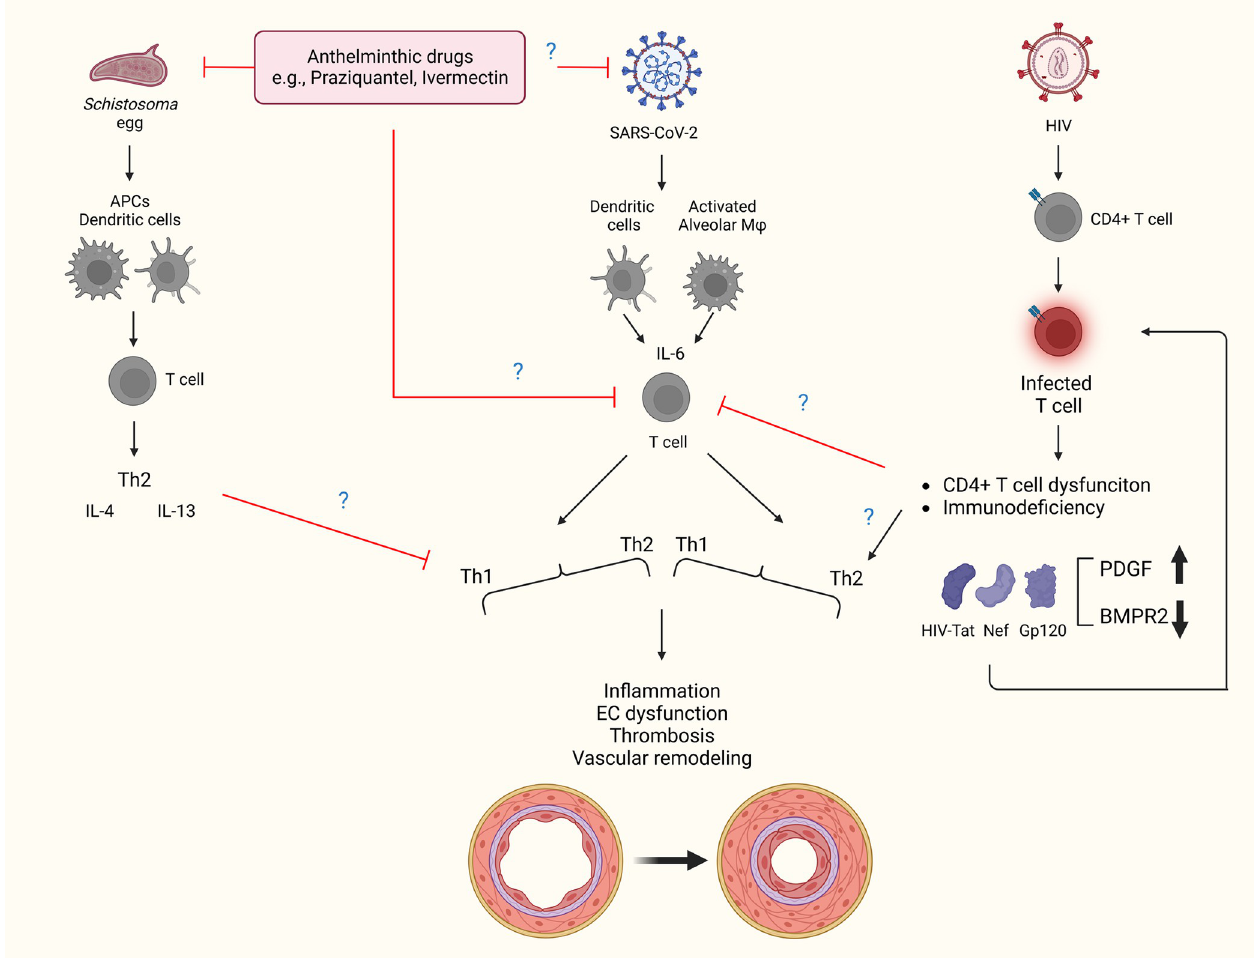
Fig 4. The schematic shows the activation of immune cells and cytokines trigged following Schistosoma , HIV, and SARS-CoV-2 infection. Schistosoma antigen is presented to dendritic cells that activates CD4 T cells to release proinflammatory IL-IL4 and IL-13 [129,252].On the other hand, SARS-CoV-2 antigen is processed by dendritic and alveolar macrophages with the release of IL-6 cytokine that eventually favors Th1-induced cytokine storms [253,254]. Schistosoma or SARS-CoV-2 infection results into releases of Ly6c monocytes from the bone marrow compartment that drives inflammatory process [255,256]. Of note, coinfection with both Schistosoma and SARS-CoV-2 might lead to higher severe conditions. However, based on the recent report on less prevalence of COVID-19 in Schistosoma -endemic regions, there is a possibility that anthelminthic drugs such as praziquantel might have antiviral property to block the replication of SARS-CoV-2 or dampen the accumulation and production of IL-6, although this was not observed clinically for ivermectin [257,258]. Blockade of IL-6 might be helpful in mitigating cytokine storm and endothelial damage. The other possibility could be the counterbalancing of Th1-induced cytokine storm by the predominance of Th2 immunity due to prior Schistosoma infection. The overall effect of Schistosoma and SARS-CoV-2 coinfection on downstream pathological features such as endothelial (EC) dysfunction. HIV proteins are known to cause endothelial dysfunction and vascular remodeling [152,218,219] via skewing the Th1-Th2 balance. HIV viral proteins Tat, Nef, and gp-120 were reported to reduce BMPR2 expressions, while Tat and gp120 can induce expression of PDGF and involving in pulmonary vascular remodeling. Further detailed studies are required to answer whether preexisting chronic HIV infection is associated with prolonged inflammation in long COVID phase. Created with BioRender.com. BMPR2, bone morphogenetic protein receptor type 2; COVID-19, Coronavirus Disease 2019; IL, interleukin; PDGF, platelet-derived growth factor; SARS-CoV-2, Severe Acute Respiratory Syndrome Coronavirus